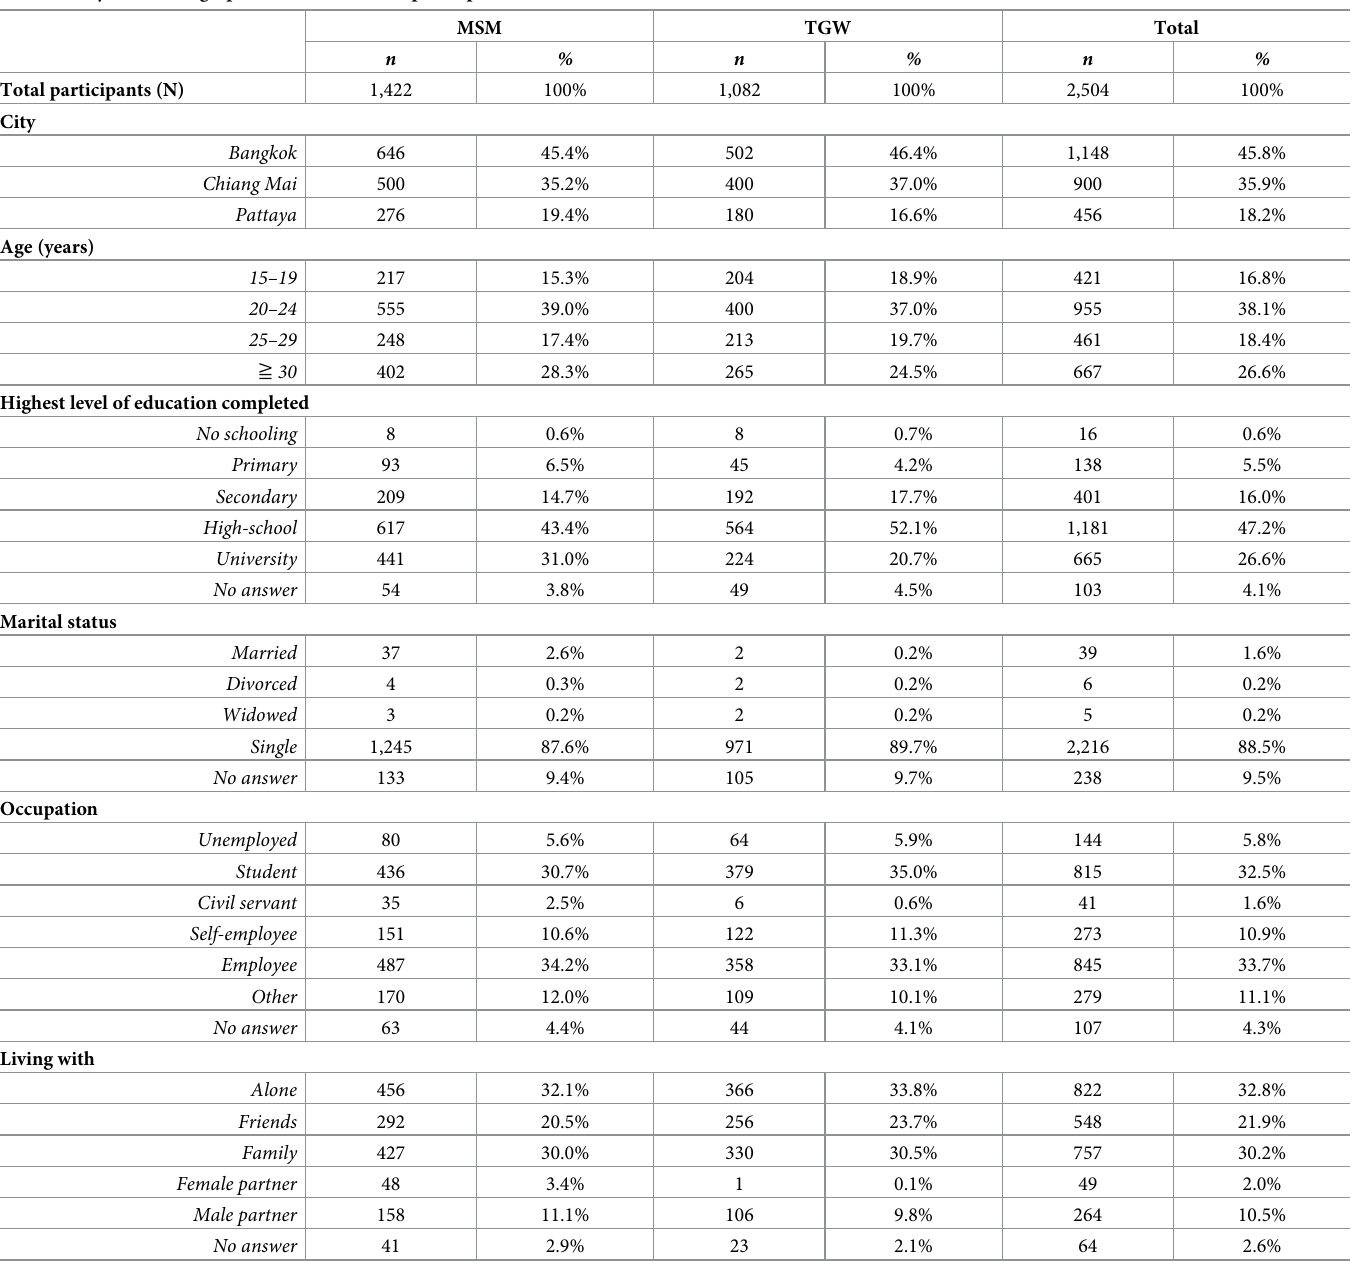
Table 1. Key sociodemographic characteristics of